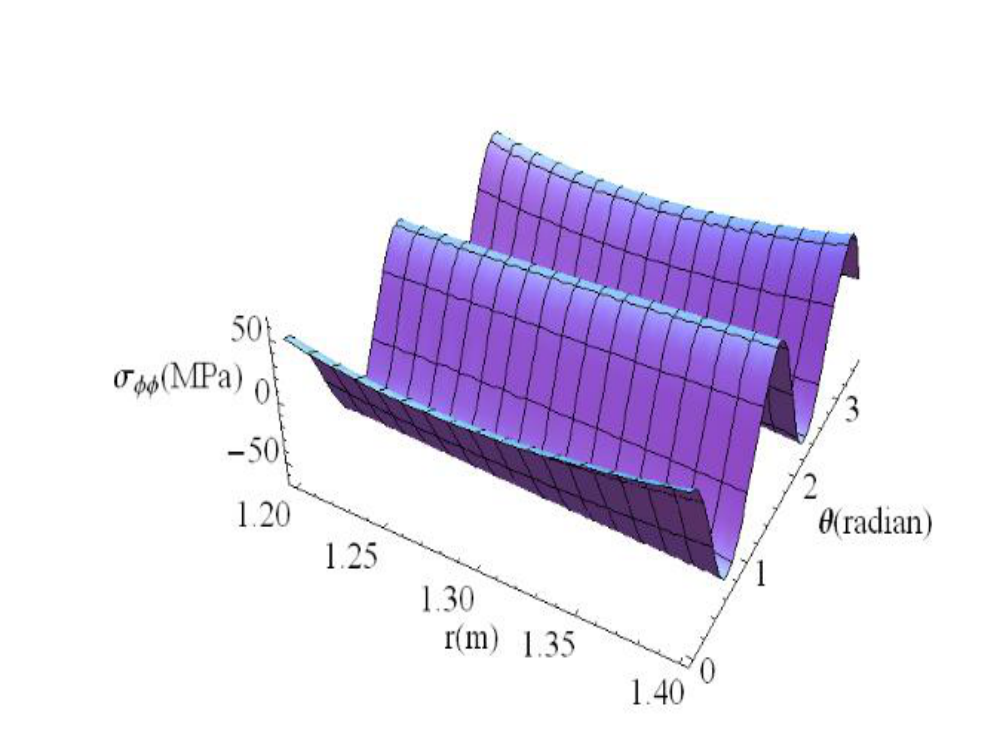
Figure 6. Azimuthal stress at 𝛽 = 2 .